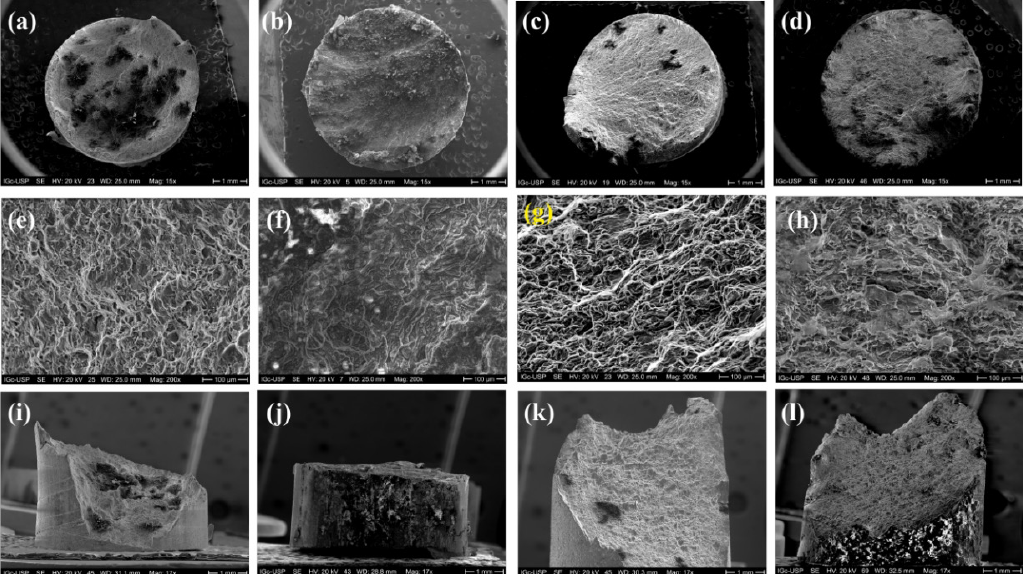
Figure 14. SE-SEM micrographs of the fracture surfaces of the PHO-20 and PHO-30 samples: a) PHO-20 cross-section; specimen tested in air; b) PHO-20 cross section; specimen tested in 0.1 M NaCl solution; c) PHO-30 cross-section; specimen tested in air; d) PHO-30 cross section; specimen tested in 0.1 M NaCl solution; e) high magnification view of (a); f) high magnification view of (b); g) high magnification view of (c); h) high magnification view of (d); i) PHO-20 side view; specimen tested in air; j) PHO-20 side view; specimen tested in 0.1 M NaCl; k) PHO-30 side view; specimen tested in air; j) PHO-30 side view; specimen tested in 0.1 M